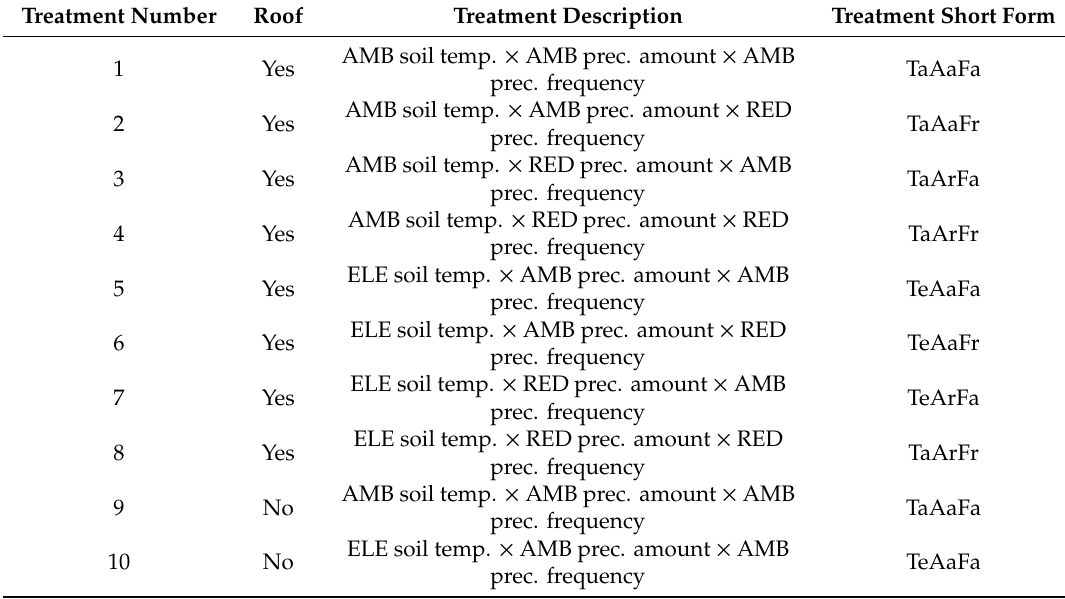
Table 1. Treatment combinations of the experiment: ambient (Ta) or elevated (Te) soil temperature in combination with the following precipitation patterns: ambient (Aa) or reduced (Ar) precipitation amount and ambient (Fa) or reduced (Fr) precipitation frequency. In treatments 1–8 oilseed rape (OSR) was grown under roofs (R1) to enable the manipulation of precipitation patterns. OSR in treatments 9 and 10 was not covered by roofs (R0), to check for a roofing e ff ect. Abbreviations: AMB = ambient; ELE = elevated; RED = reduced; temp. = temperature; prec. =